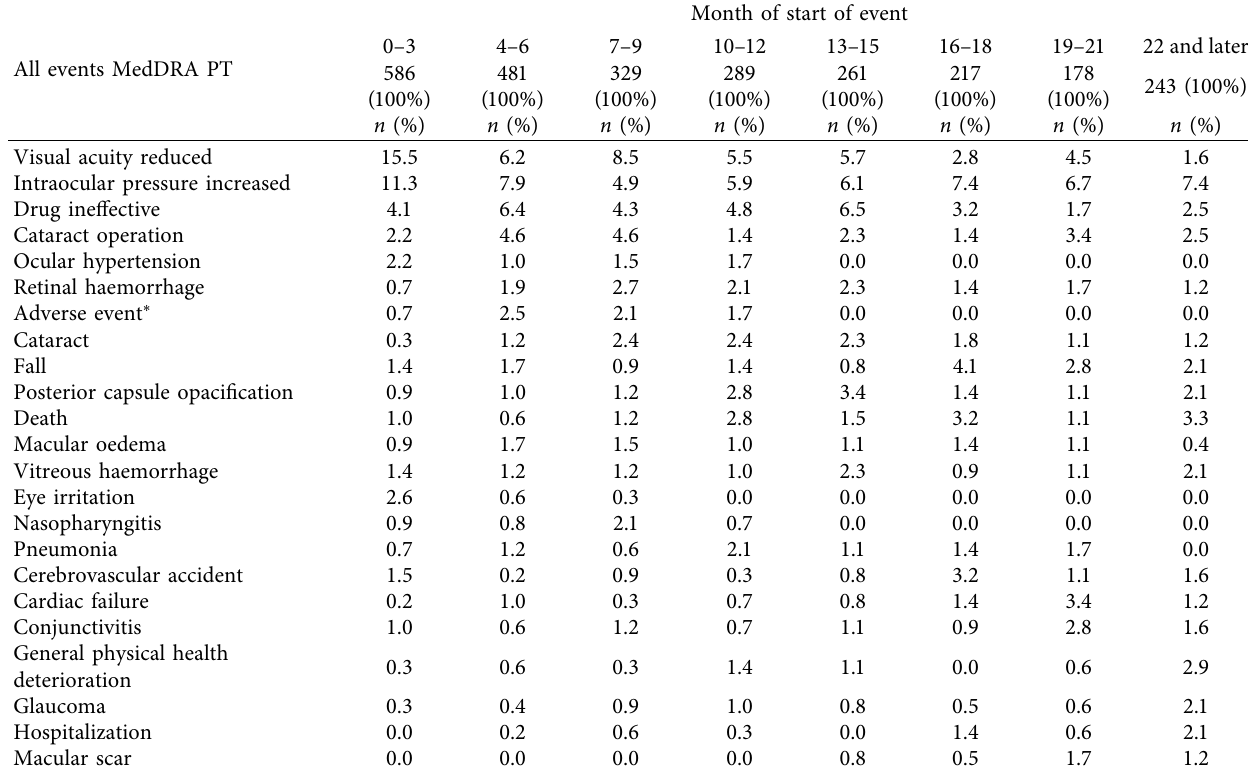
Table 3: Most frequently reported adverse events (MedDRA PTs), by time point of occurrence.